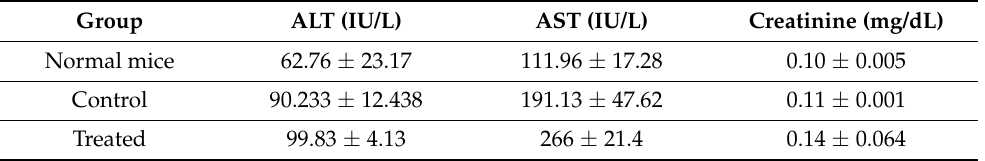
Table 6. Serum ALT, AST levels (IU/L), and serum creatinine levels in ( µ mol/L) for treatments, control, and normal untreated mice